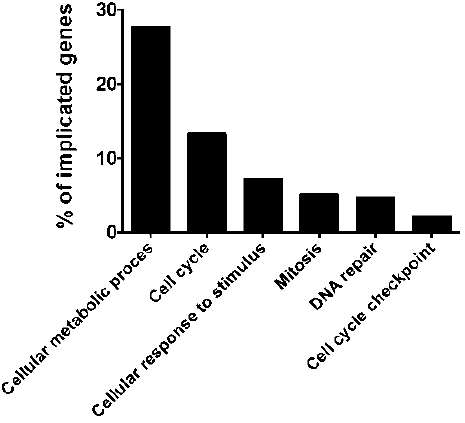
Asterisks indicate data from validation methods; NGS, next-generation sequencing; pSILAC, stable isotope labeling by amino acid in cell culture.